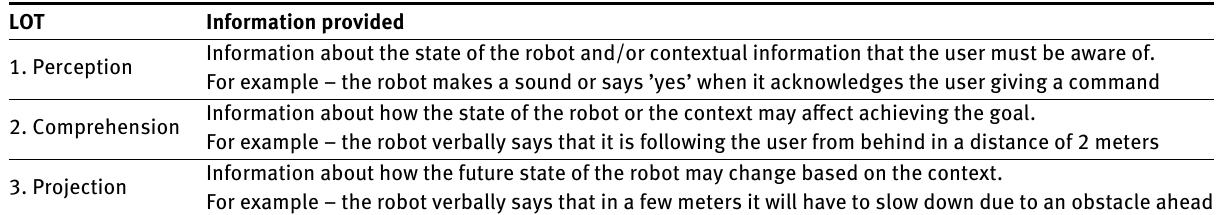
Table 1: Information provided at various